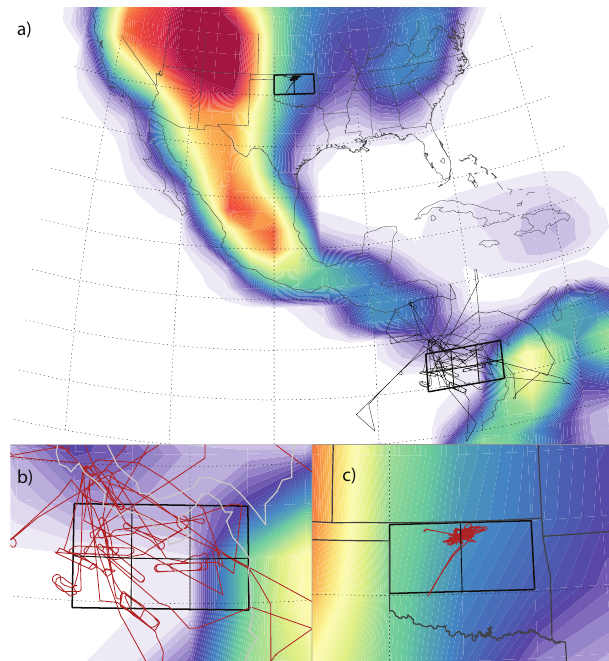
Fig. 1. a) Location of ARM-­‐IOP and TC4, along with model grid boxes. b) TC4 with a 951 more detailed view of the flight tracks. c) Same as in b) but for ARM-­‐IOP. 952 Figure 1. (a) Location of ARM-IOP and TC4, along with model 953 grid boxes. (b) TC4 with a more detailed view of the flight tracks. (c) Same as in (b) but for